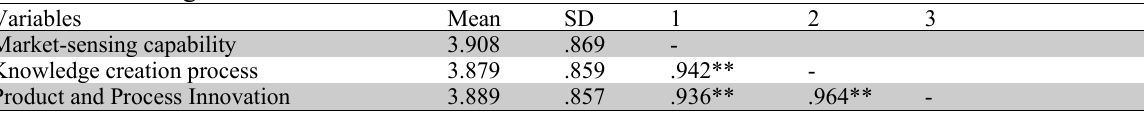
Correlations using Pearson coefficients in SPSS